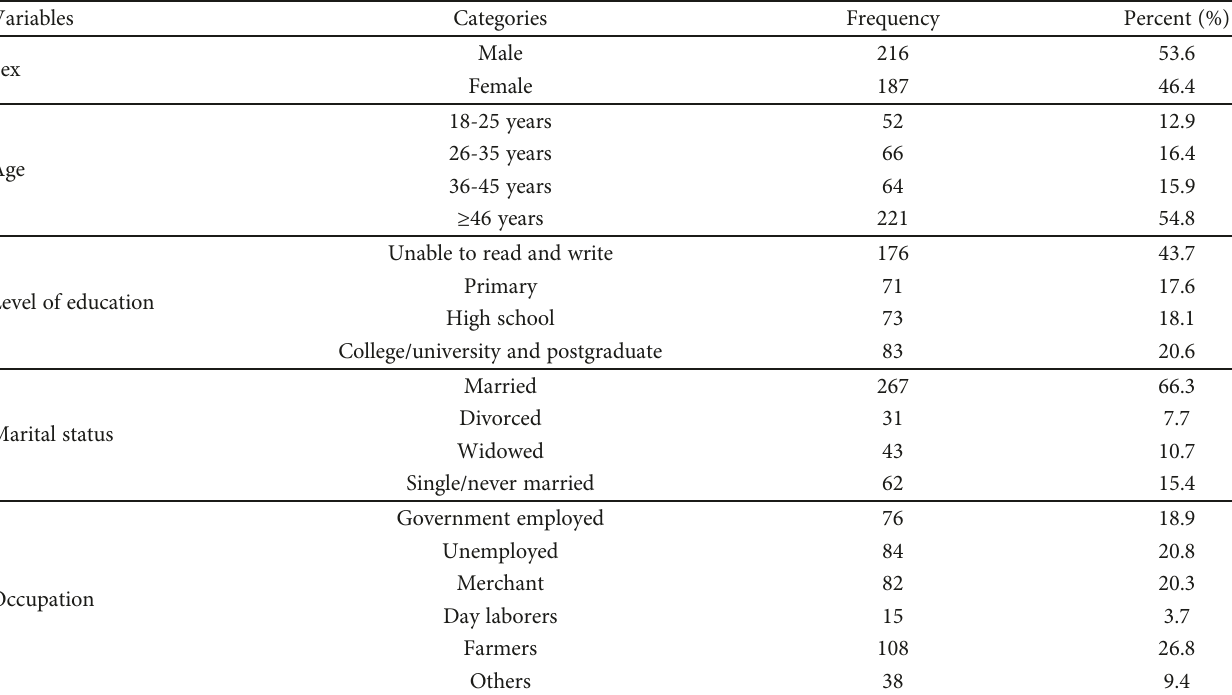
Table 1: Sociodemographic characteristics of the study participants, at the University of Gondar Hospital, 2018.